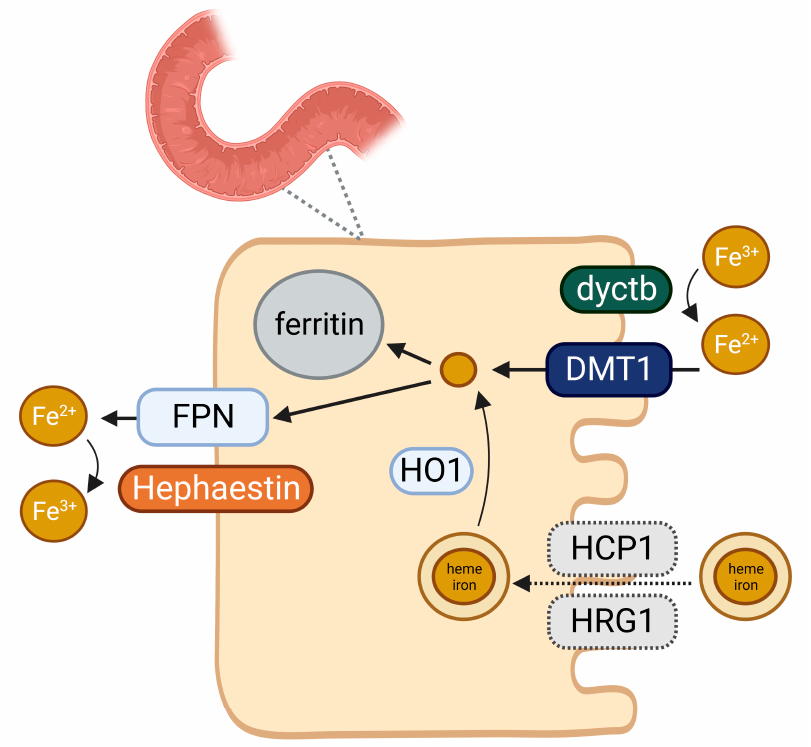
Figure 1. Overview of iron absorption in the gut. Dyctb: duodenal ferrireductase cytochrome B. DMT1: divalent metal transporter 1. HCP1: heme carrier protein 1. HRG-1: heme responsive gene 1. HO1: heme oxygenase-1. FPN: ferroportin. Created with